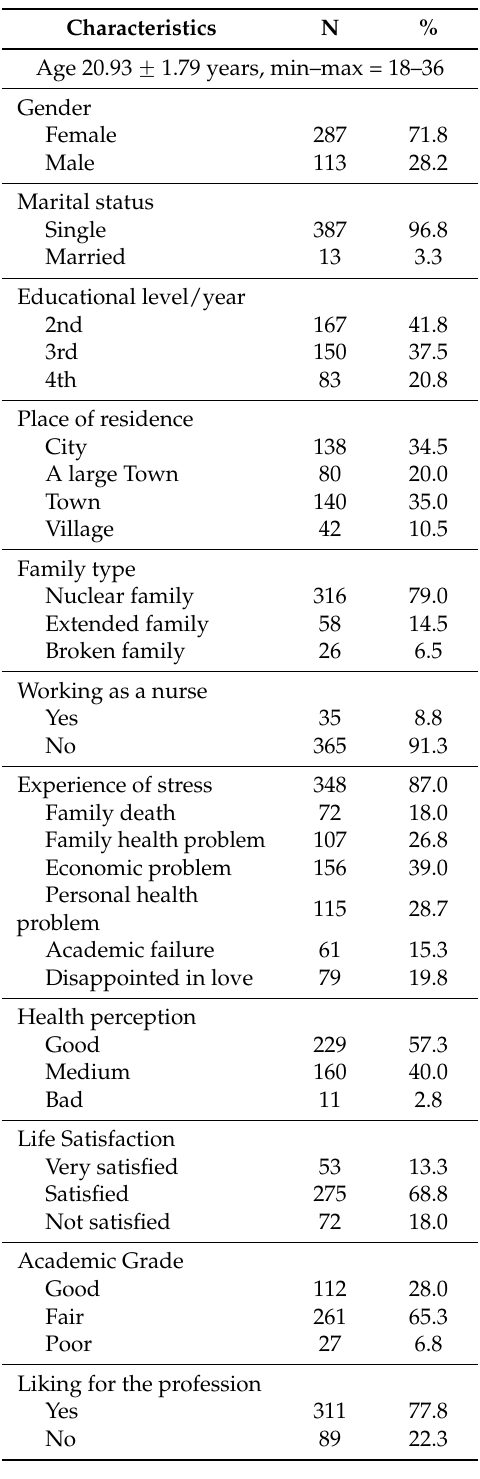
Table 1. Socio-demographic characteristics of the nursing students ( n =